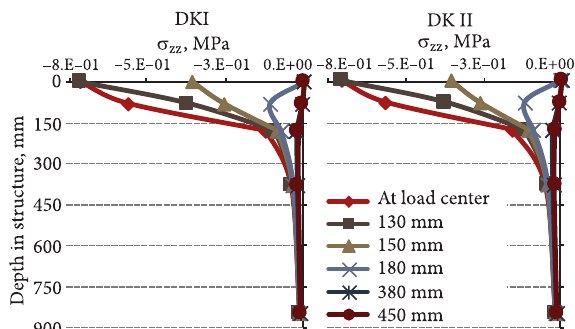
Fig. 7. The limit load according to aggregate base layer resistance to permanent deformation